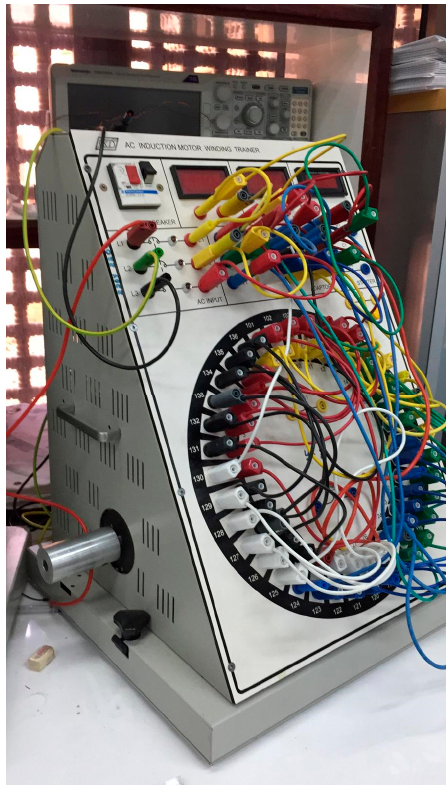
(d) Figure 16. ( a ) Symmetrical six-phase output with star-connected primary; ( b ) quasi six-phase output with primary in star; ( c ) symmetrical six-phase output with Delta-connected primary; ( d ) quasi six- phase output with delta-connected primary. The six-phase symmetrical motor is obtained by connecting the modular stator windings in such